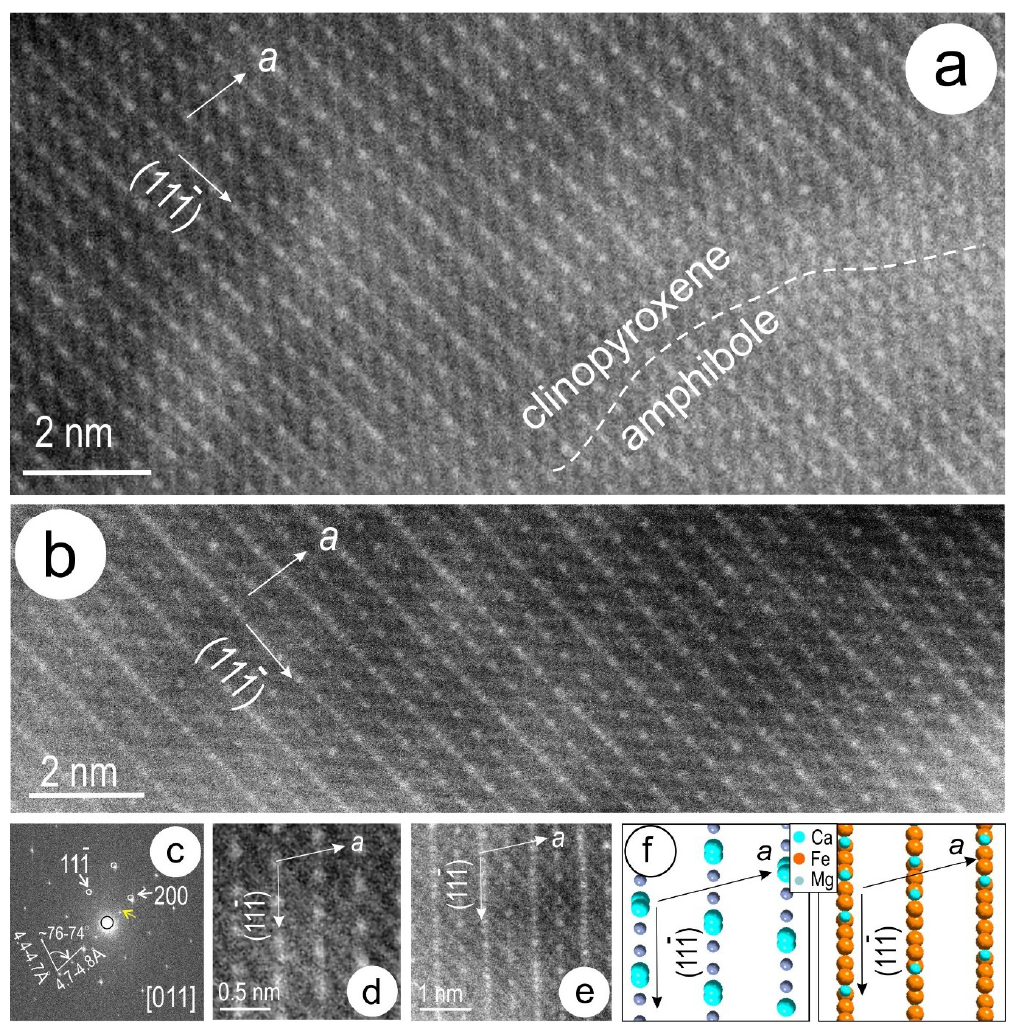
Figure 15. ( a , b ) High-resolution HAADF STEM images showing stacking intergrowths between calcic clinopyroxene and amphibole on [011] zone axis (inclusion from Supplementary Material Figure S4, foil #4). ( c ) Fast Fourier Transform (FFT) of image in (a) showing diopside and actinolite on [011] zone axis. Note the satellite reflections along a* (yellow arrow) corresponding to the amphibole. The two phases have comparable angles at 76° and 74°, respectively, between the lattice vectors (111) * and a *. ( d – f ) Images and crystal structures corresponding to diopside and actinolite on [011] zone axis. Bright atoms correspond to cations with denser packing on (111) for the amphibole (e and right on f) relative to the clinopyroxene (d and left on f).